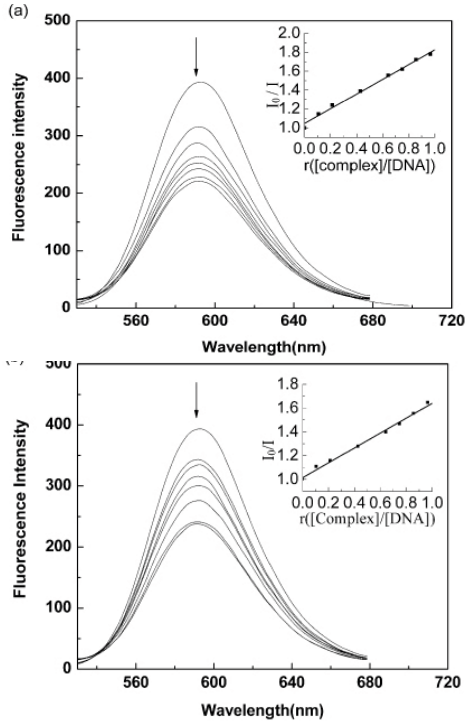
Figure 4 . Emission spectra of EB-DNA system in the absence and presence of La(III) complex (a) and Gd(III) complex (b) λ = 530 - 680 nm. Arows show the emission intensity changes upon λ em the increasing concentration of the complexes. Insert: Stern–Volmer plots of the fluorescence titration data of the complexes with the standard deviations of 0.03, 0.02 and the linear correlation coefficients of 0.9965, 0.9968 for (a) and (b), respectively. In all cases: [DNA] = 37.2 μmol L -1 ; [EB] = 5 μmol L -1 ; r ([Complex]/[DNA]) = 0, 0.11, 0.22, 0.43, 0.64, 0.75, 0.86, 0.97, respectively.